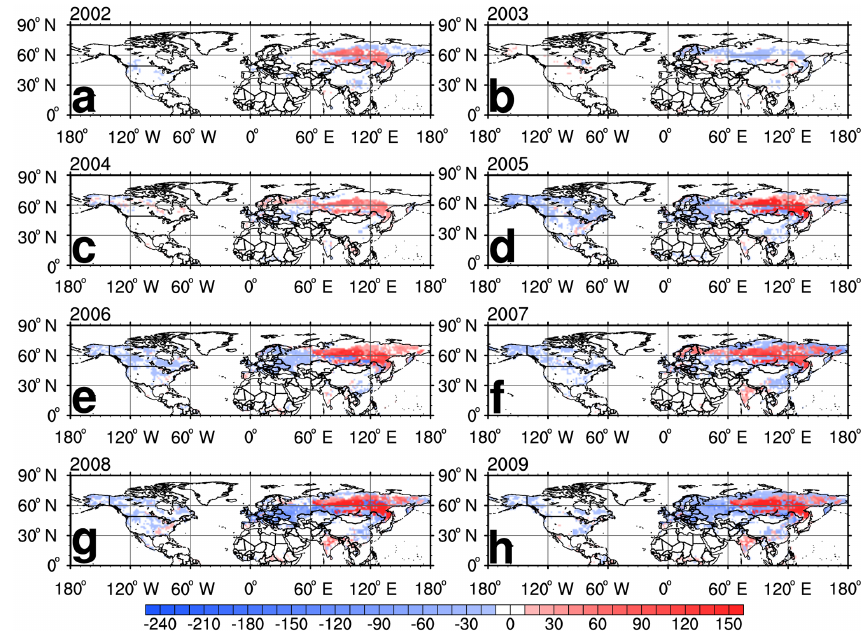
Figure 3. The difference between the optimized biosphere fluxes from the JR and CNTL experiment (gCm − 2 yr − 1 ) of (a) 2002, (b) 2003, (c) 2004, (d) 2005, (e) 2006, (f) 2007, (g) 2008, and (h) 2009. Blue colors (negative) denote net CO 2 flux uptake while red colors (positive) denote net CO 2 release to the atmosphere. The difference is calculated by subtracting surface CO 2 flux of the CNTL experiment from that of the JR experiment. Table 3. The optimized surface CO 2 fluxes (PgCyr − 1 region − 1 ) of ecosystem types at Eurasian boreal, Eurasian temperate, Europe, North American boreal, and North American temperate region averaged over 2002–2009. The CNTL experiment is conducted by using a set of observations without observations in the Siberia region, whereas the JR experiment is conducted using all available observations including the Siberia data.